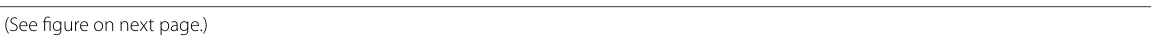
figure on next Fig. 4 Calculated past temperature changes at the lower and upper depth limits of equivalent climate change surface air boundary layer (top), equivalent climate change waters surface boundary layer (middle), and equivalent climate change land surface boundary layer (bottom), and the temperature change forecast as well as their observed temperature anomalies under scenario